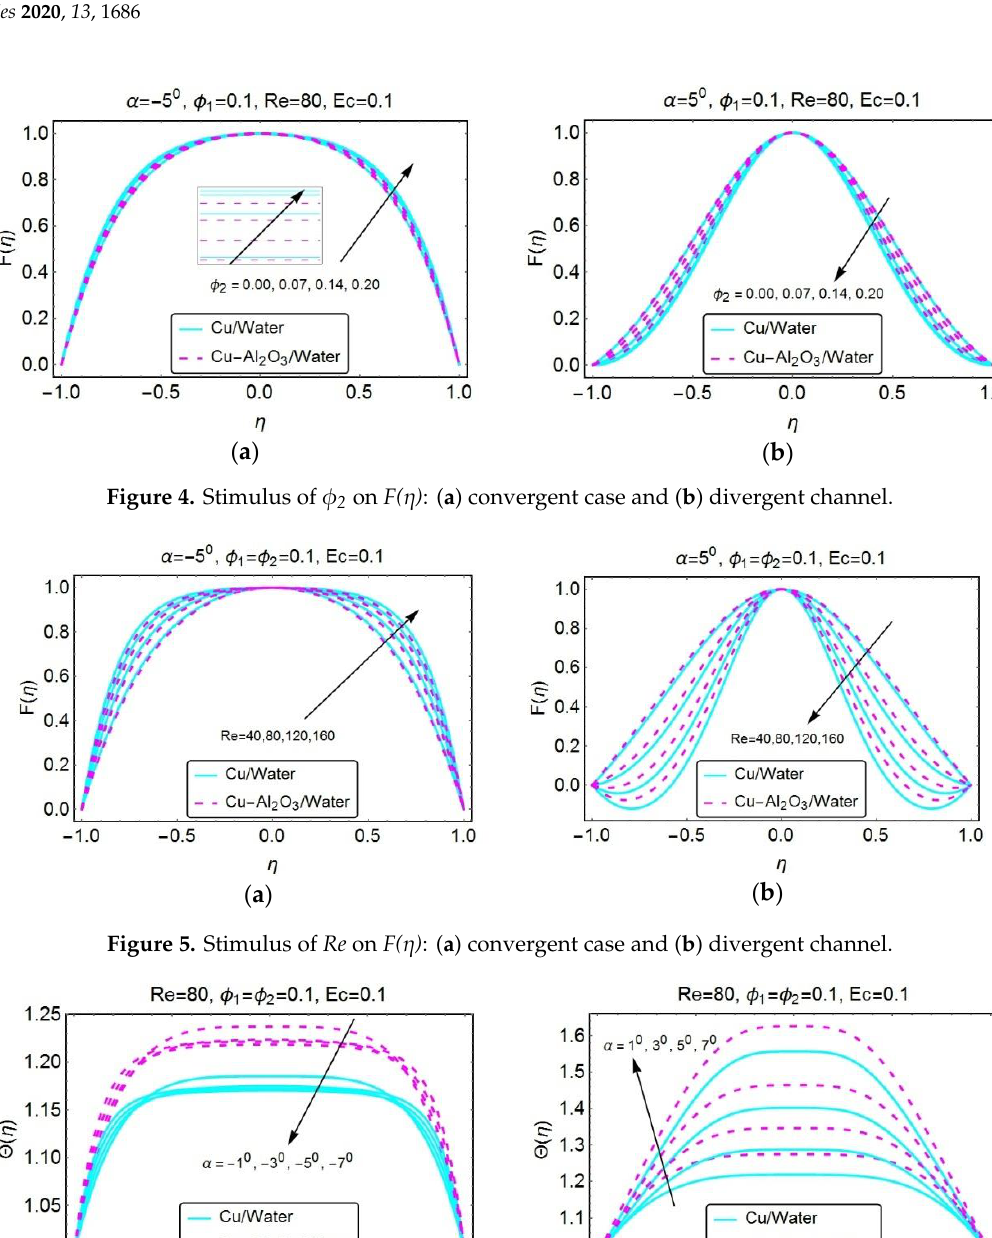
Figure 3. Stimulus of α on F(η) : ( a ) convergent case ( b ) divergent channel.